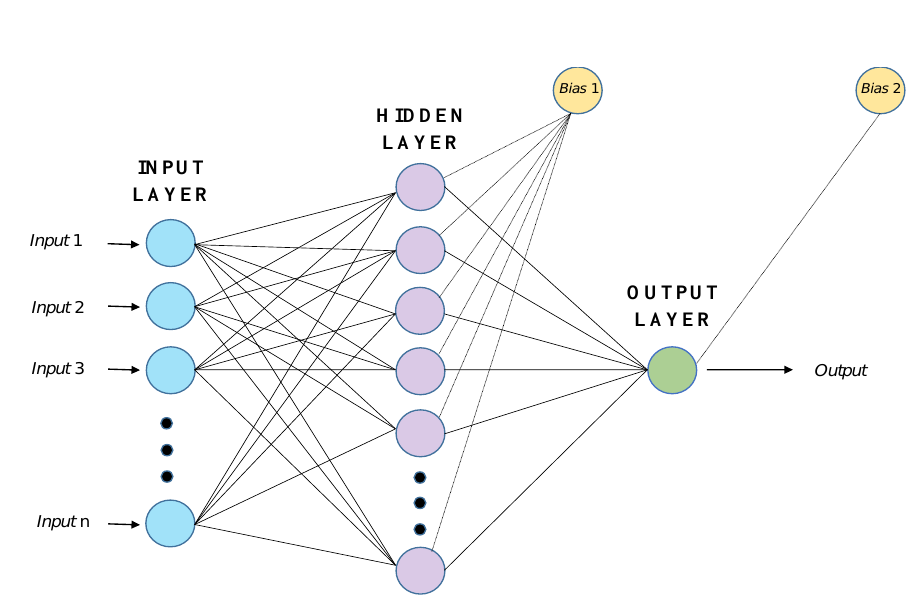
Figure 2. Multilayer perceptron (MLP) technique in